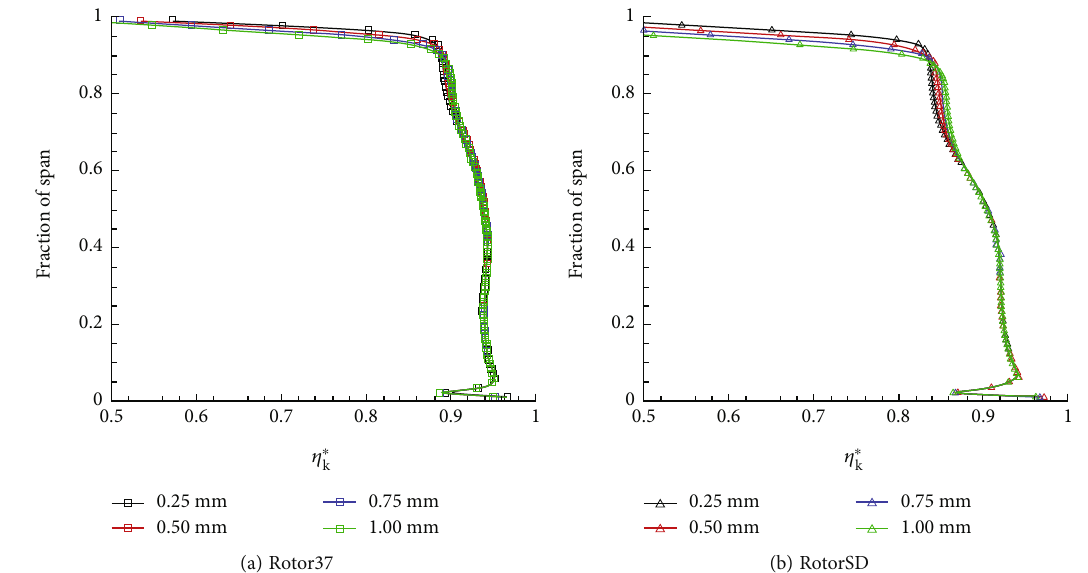
Figure 17: Distribution of the isentropic e ffi ciency along the span at 70% of the design speed.